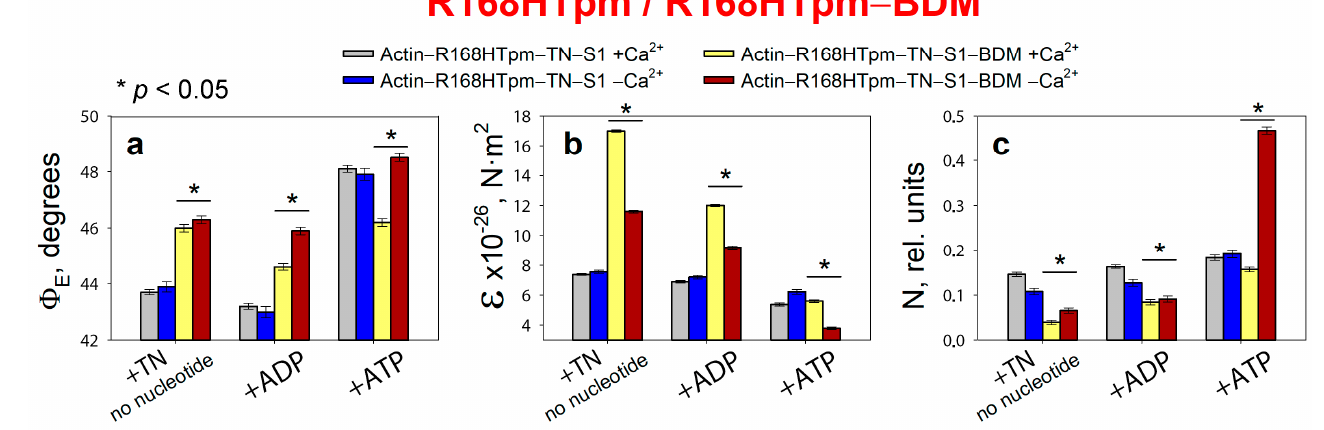
Figure 5. Effect of 20 mM 2,3-butanedione monoxime (BDM) on the values of Φ E ( a ), ɛ ( b ), and N ( c ) of polarized fluorescence of S1-AEDANS in the presence of R168HTpm in ghost muscle fibers under conditions simulating the sequential steps of the actomyosin ATPase cycle. The results were obtained in the same experiment when the muscle fibers containing the R168HTpm without BDM were used as a control. The data are presented as mean ± SEM. * p < 0.05 = difference between R168HTpm and R168HTpm–BDM.